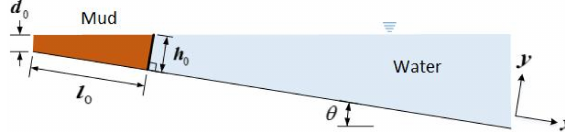
Figure 10. Submarine landslide.